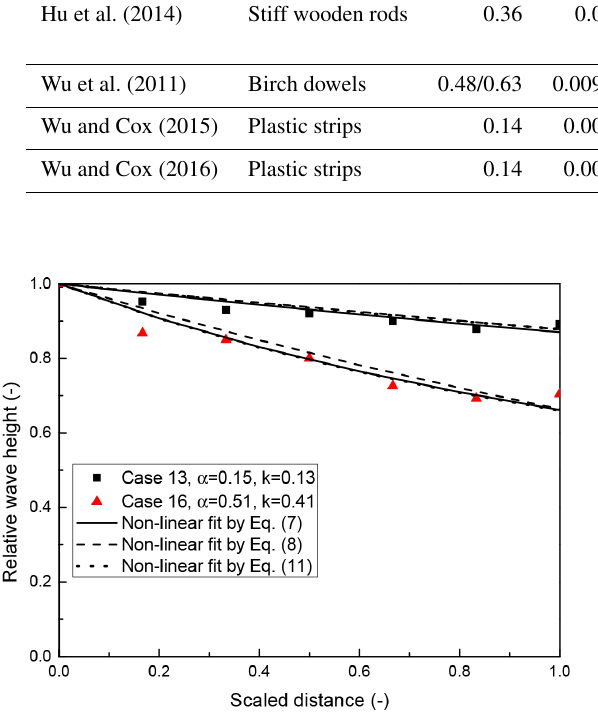
Figure 2. Measured and predicted wave attenuation. Square and triangle symbols indicate measurements of cases 13 and 16; solid, dashed, and dotted lines represent the curves fitted by Eqs. (7), (8), and (11), respectively.